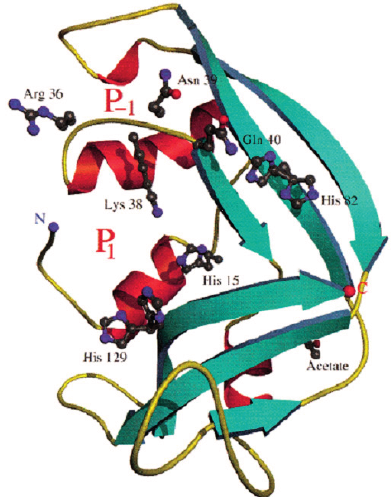
Figure 2. Ribbon diagram of the three-dimensional structure of human EDN. The relative positions of catalytic His 15, His 129, and Lys 38 are as shown, structure determined at 0.98 angstroms. Reprinted from [30] with permission from American Chemical